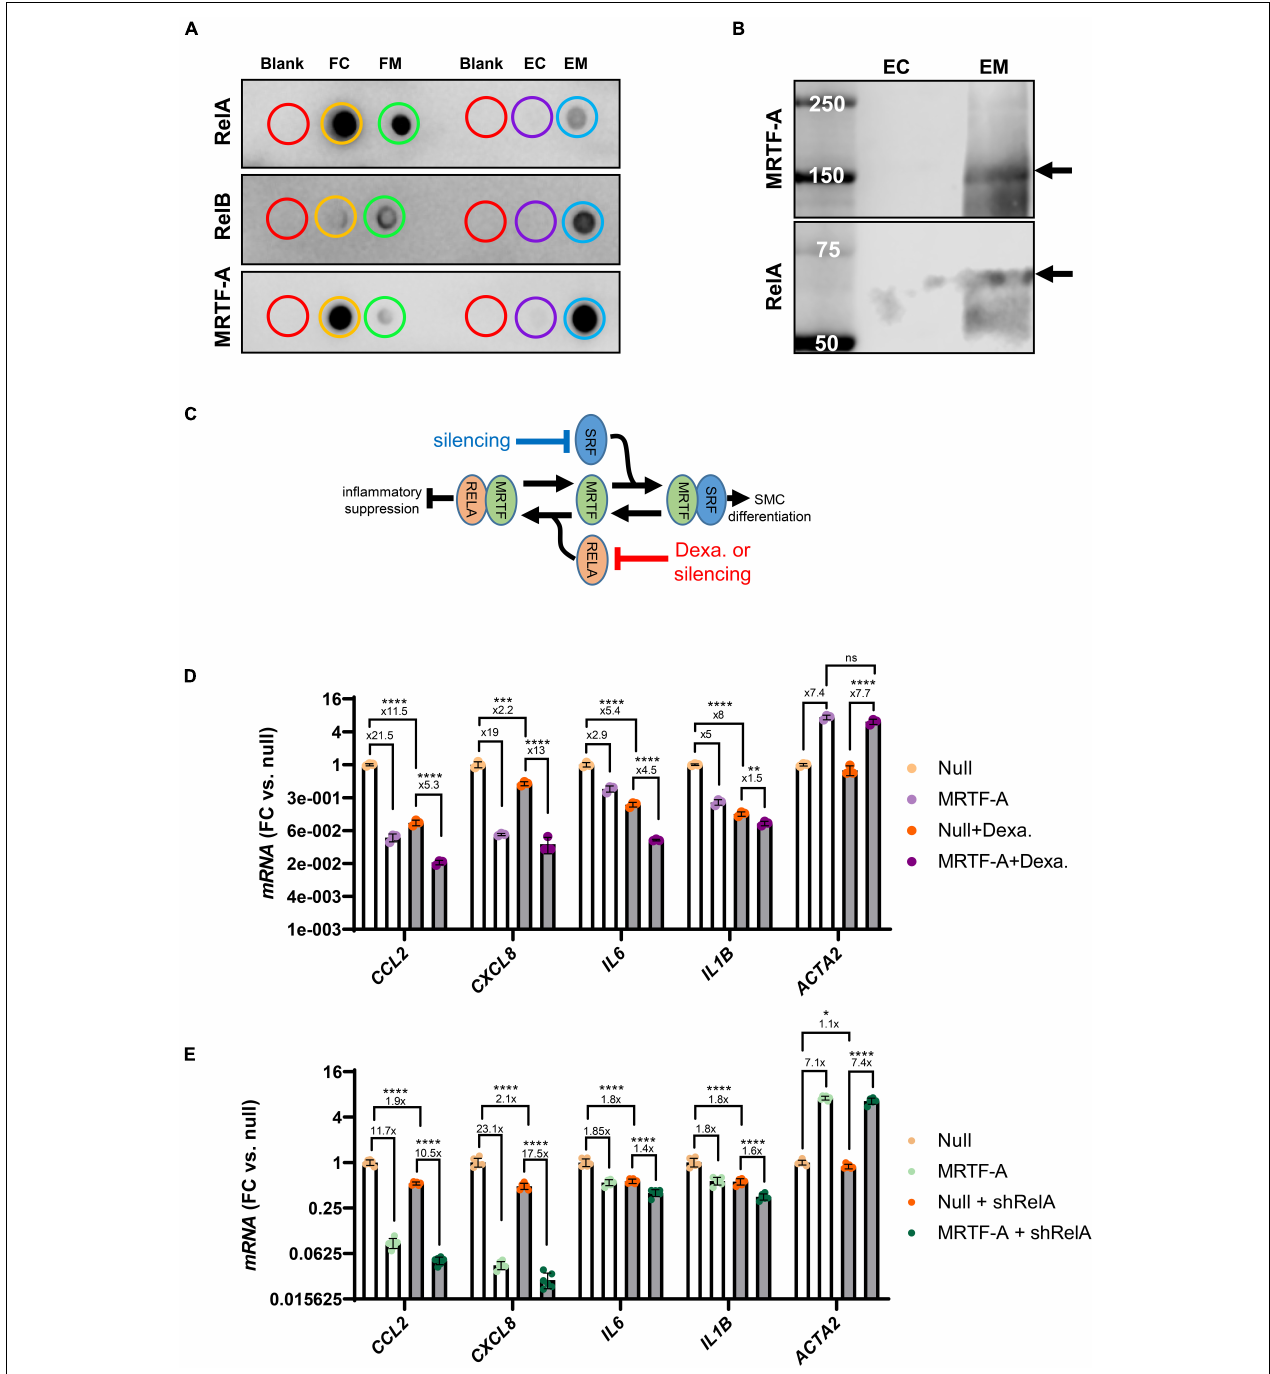
FIGURE 5 | MRTF-A interacts with RelA and RelB. To explore if MRTF-A binds RelA and RelB, we performed co-immunoprecipitations followed by dot blotting (A) . Lysates from cells where MRTF-A was overexpressed were incubated with control resin and with MRTF-A-antibody-conjugated resin. Flow through (FC: flow through control; FM: flow through MRTF-A) from both columns contained RelA, RelB, and MRTF-A. RelA, RelB and MRTF-A were moreover detectable in the eluate from the MRTF-A column (EM: eluate MRTF-A) but in the in the eluate from the control column (EC: eluate control). Western blotting (B) of the eluates showed the RelA band at the expected molecular weight. These findings support a model where MRTF binding to Rel proteins suppresses inflammation (C) . (C) Also depicts the hypothesis that RelA suppression, by glucocorticoid receptor stimulation or silencing, should mitigate inflammatory suppression by MRTF-A. (D,E) Test this hypothesis using dexamethasone (glucocorticoid receptor agonist, 3 µ M) or short hairpin silencing (200 MOI of shRELA). For the experiments in (D,E) , the fold repression is given. Independent testing showed that the fold repression of CCL2 and IL1B by MRTF-A was reduced by dexamethasone. In contrast, fold suppression of CXCL8 and IL6 was unaffected. For RelA silencing, CXCL8 and IL6 suppression by MRTF-A were significantly reduced, but the overall effect, where MRTF-A suppression of inflammation was reduced by ≈ 25%, was also significant. * P < 0.05, ** P < 0.01, *** P < 0.001, **** P < 0.0001.